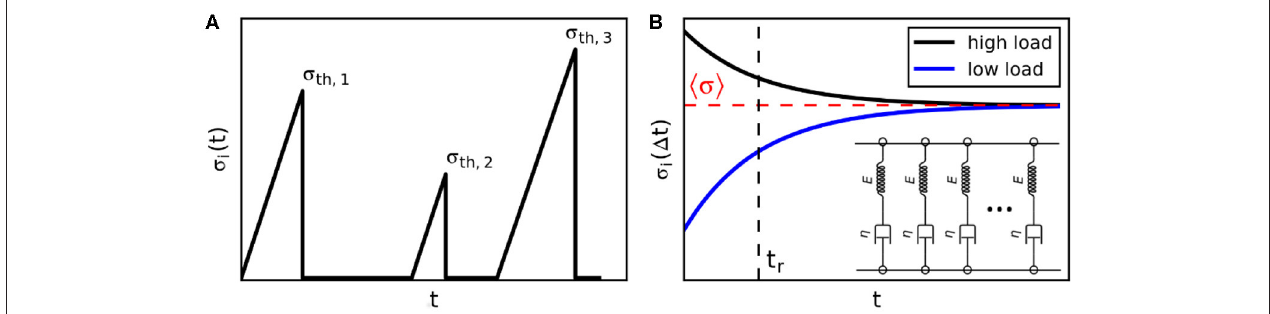
FIGURE 4 | (A) Load evolution for a single fiber when healing is included. The load increases until the strength σ th,1 is reached and the fiber fails. After a certain random time, the fiber heals and is assigned a new strength σ th,2 independent of the previous strength; subsequently it may fail and sinter again. (B) Relaxation of load on the single fibers toward the mean load h σ i for the FBM assuming viscoelastic fibers (schematic in inset). The speed of the load relaxation is controlled by the characteristic loading time t r . Figures adapted from